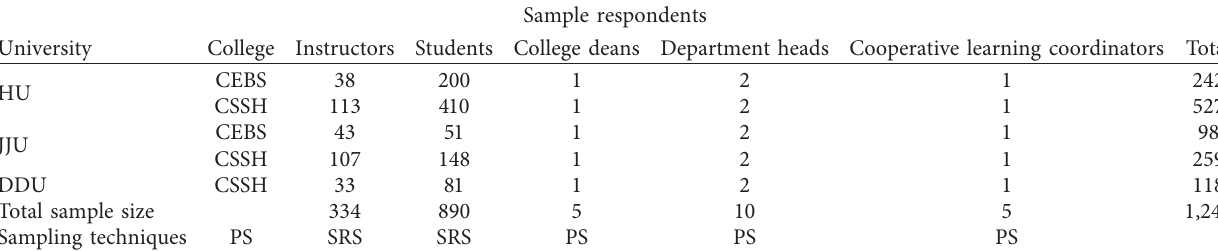
Table 1: Sample size and sampling